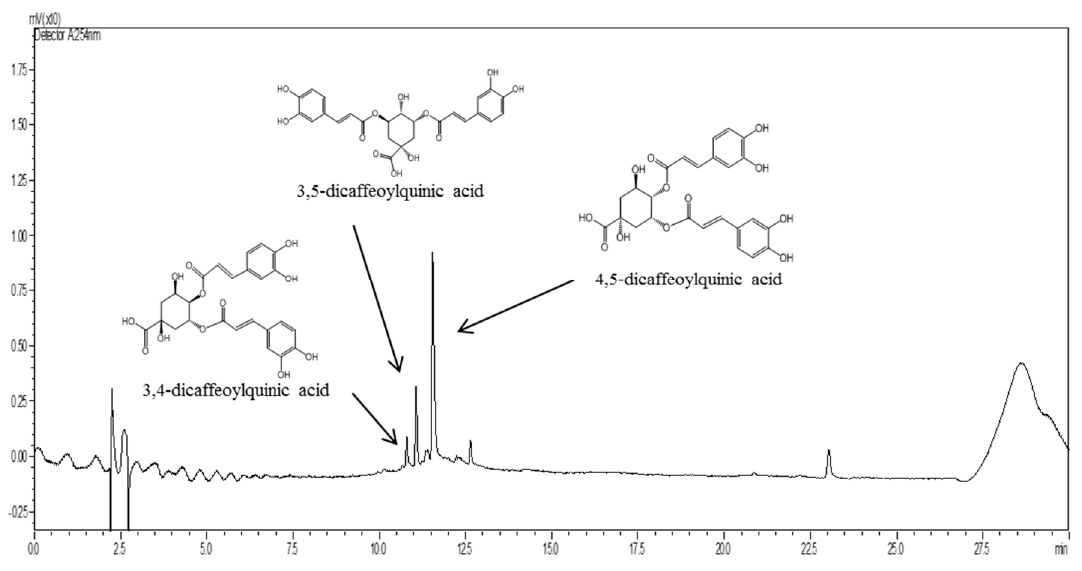
Figure 1. Representative HPLC-MS chromatogram of 3,4-dicaffeoylquninic acid, 3,5-dicaffeoylquinic acid, and 4,5-dicaffeoylquninic acid in Petasites japonicus leaf (PL).